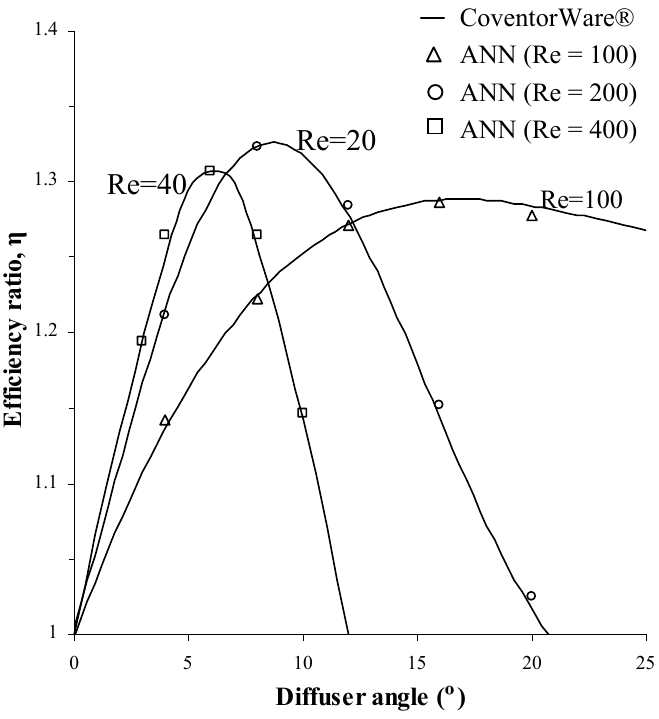
Figure 9. Comparison of efficiency ratio obtained from CoventorWare® simulations with ANN predictions for variations in diffuser angle at different Re numbers.